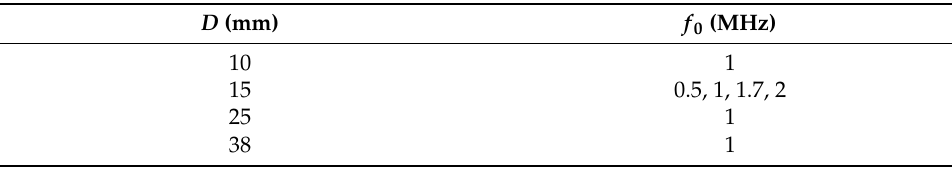
Table 2. Experimental piezoelectric ceramic (PZT) plates specifications.